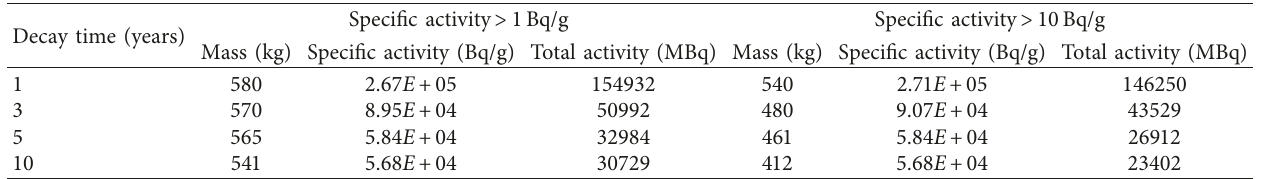
Table 8: Activity of aluminum in the reactor components (except in the